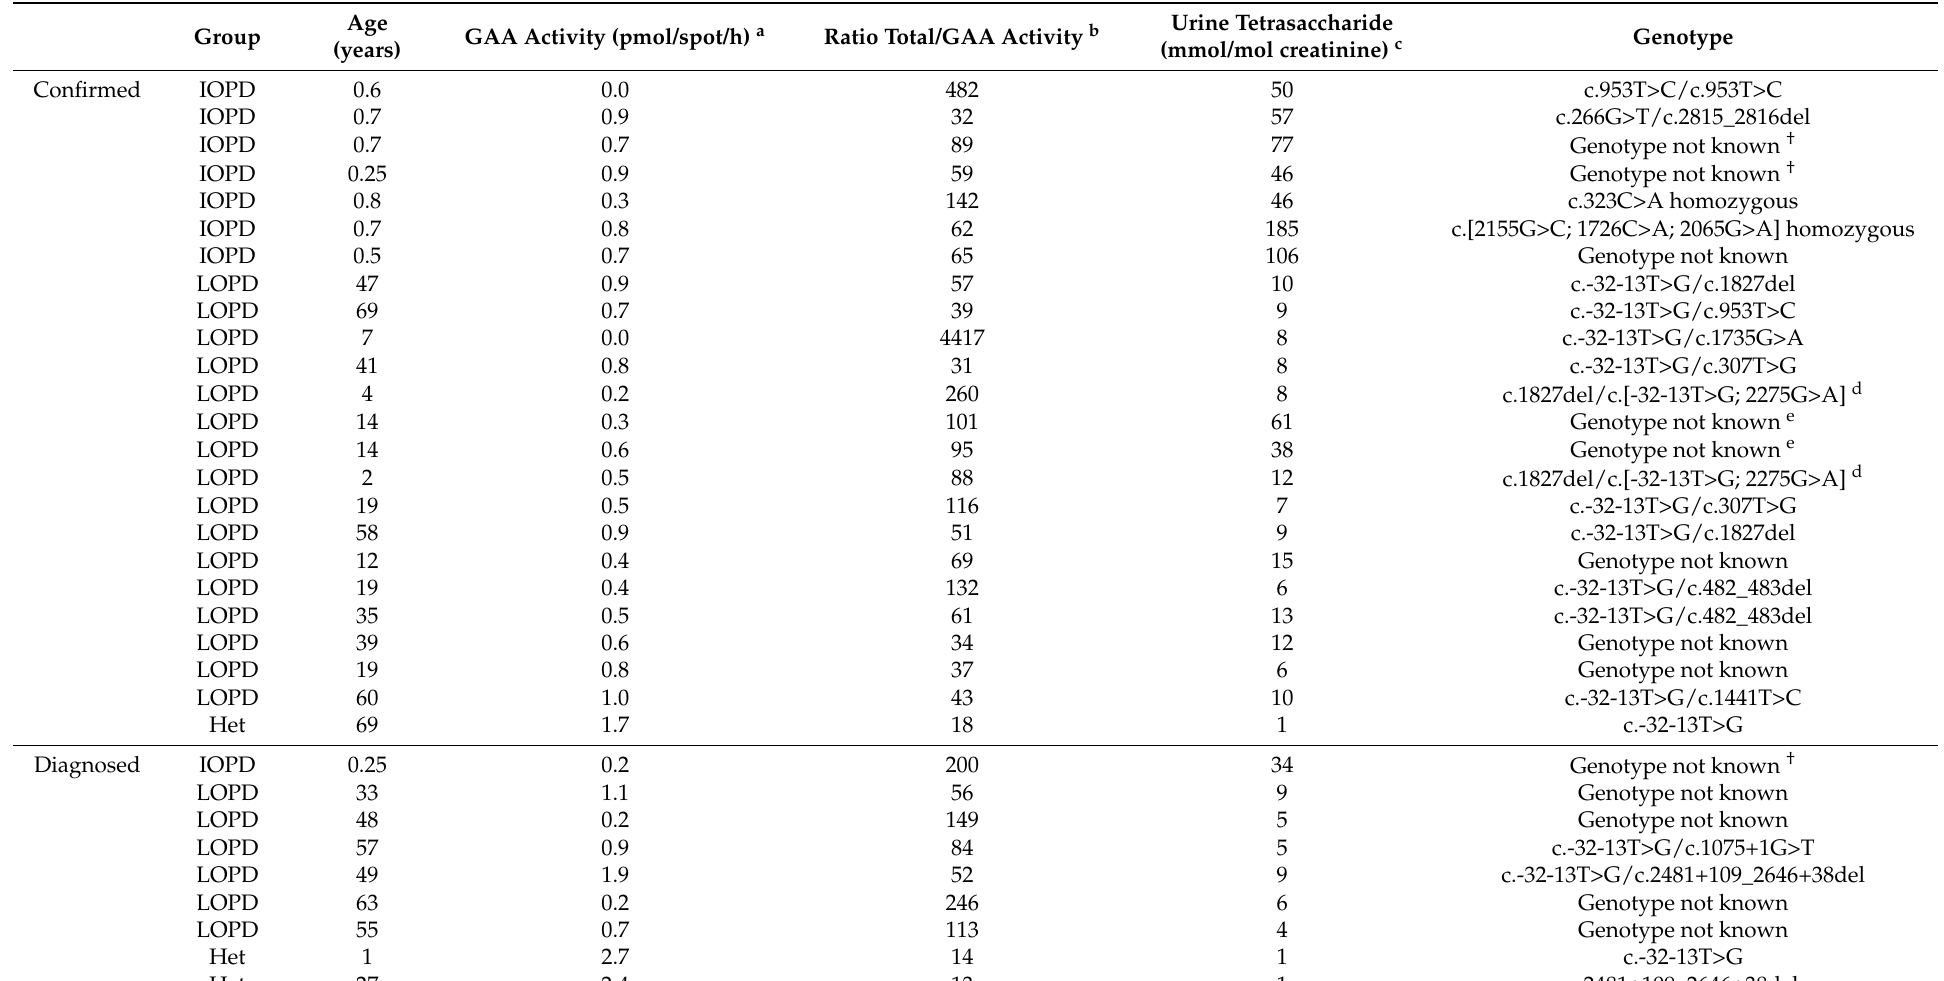
Table 1. GAA activity, urine tetrasaccharide concentration and genotype of patients previously confirmed with Pompe disease, as well as those diagnosed since the initiation of the urine tetrasaccharide assay within the diagnostic